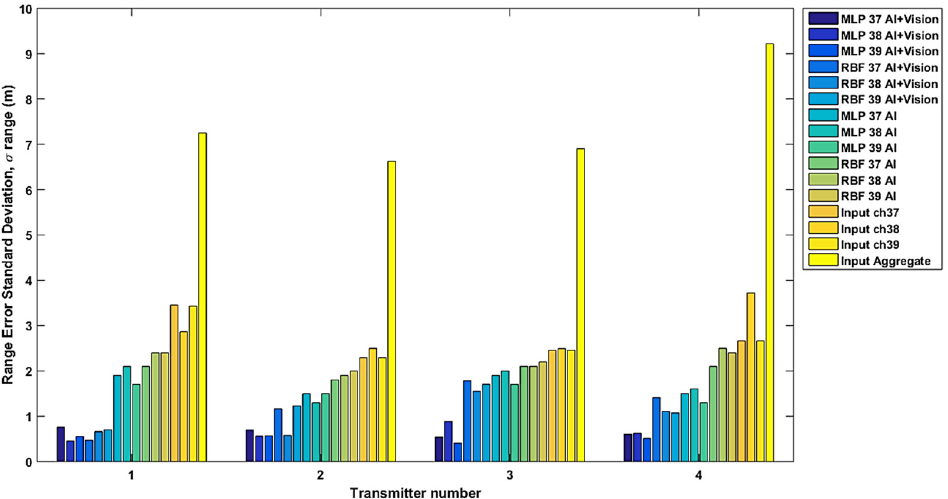
Figure 17. The standard deviation of the distance error before (input) and after the RSSI correction, using MLP and RBF with RSSI only (AI) [24] and using MLP and RBF with RSSI and vision information (AI+ Vision).